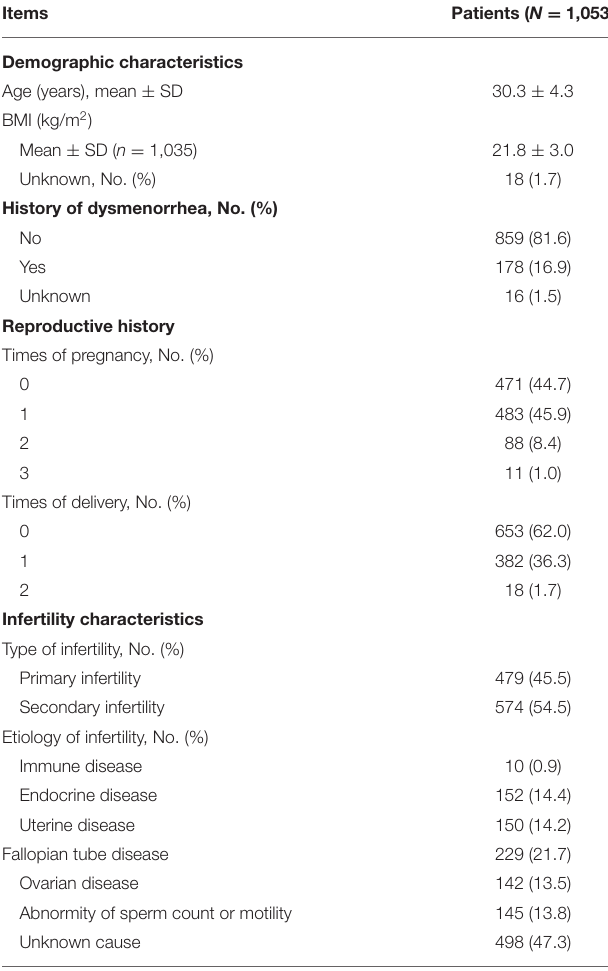
TABLE 1 | Clinical